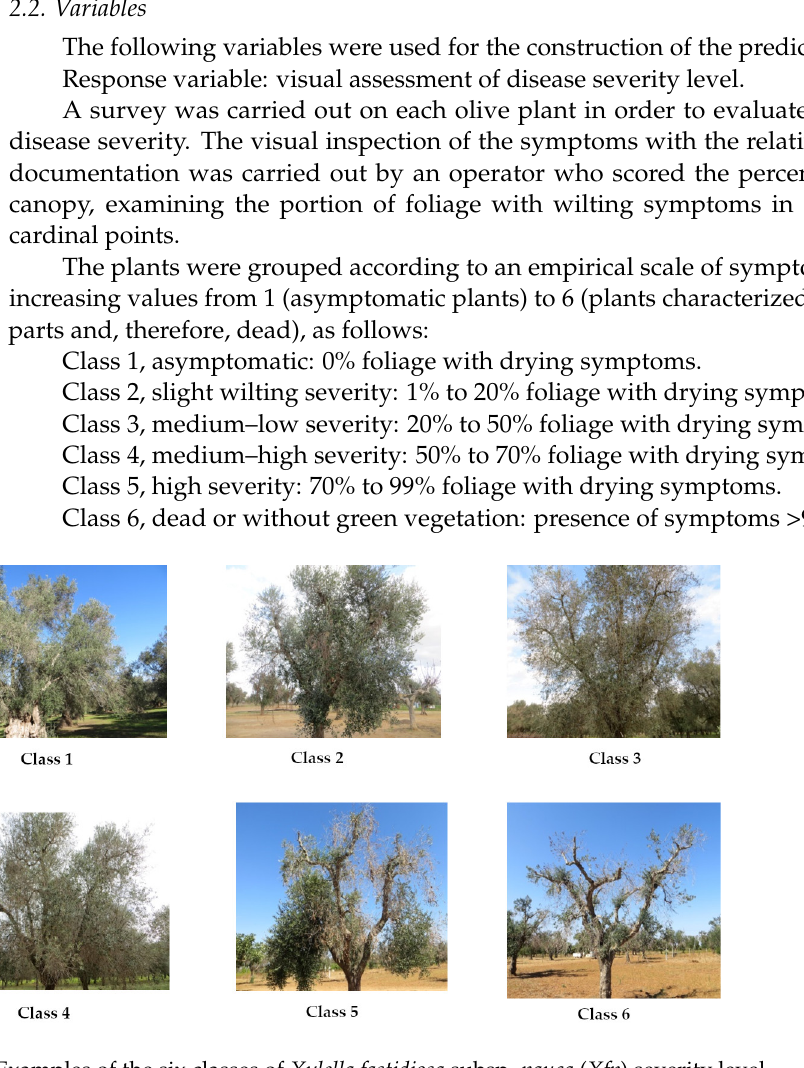
Figure 2. Examples of the six classes of Xylella fastidiosa subsp. pauca ( Xfp ) severity